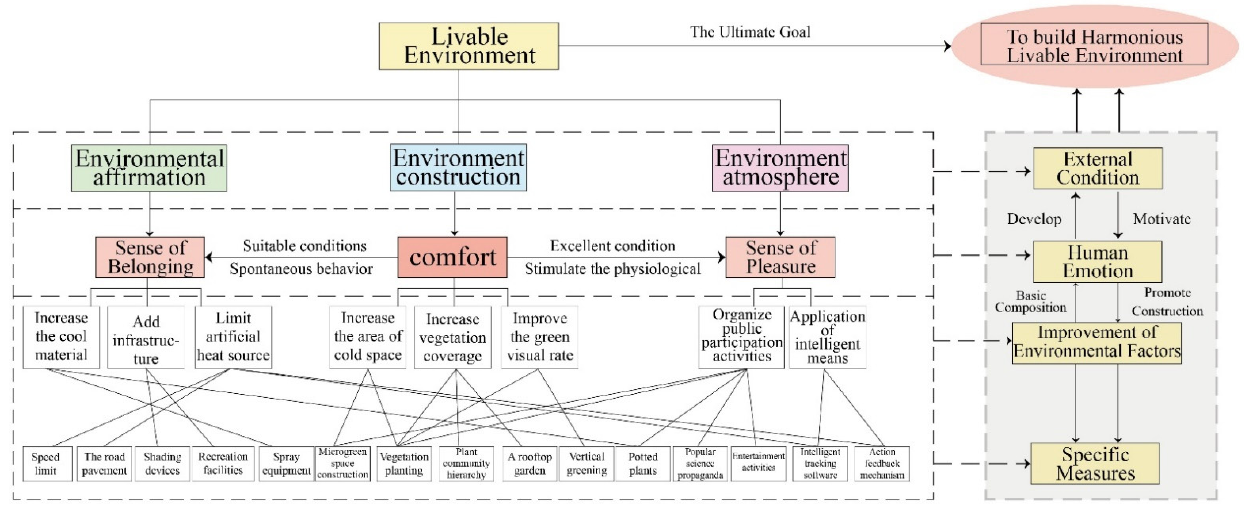
Figure 9. Mitigation countermeasures of high-risk heat exposure spaces from the humanistic per- spective.